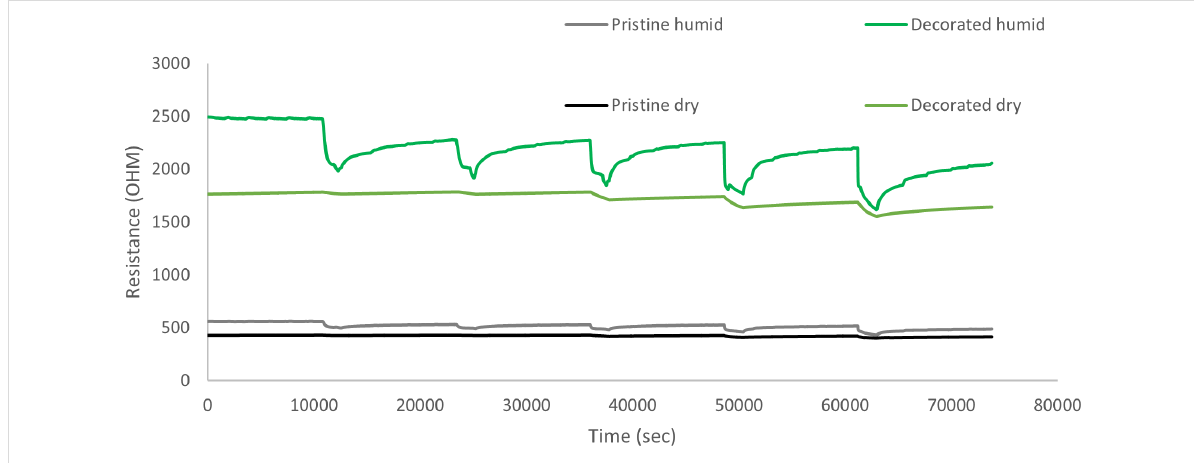
Figure 12: Comparison between gas sensors – performance in both dry and humid conditions.